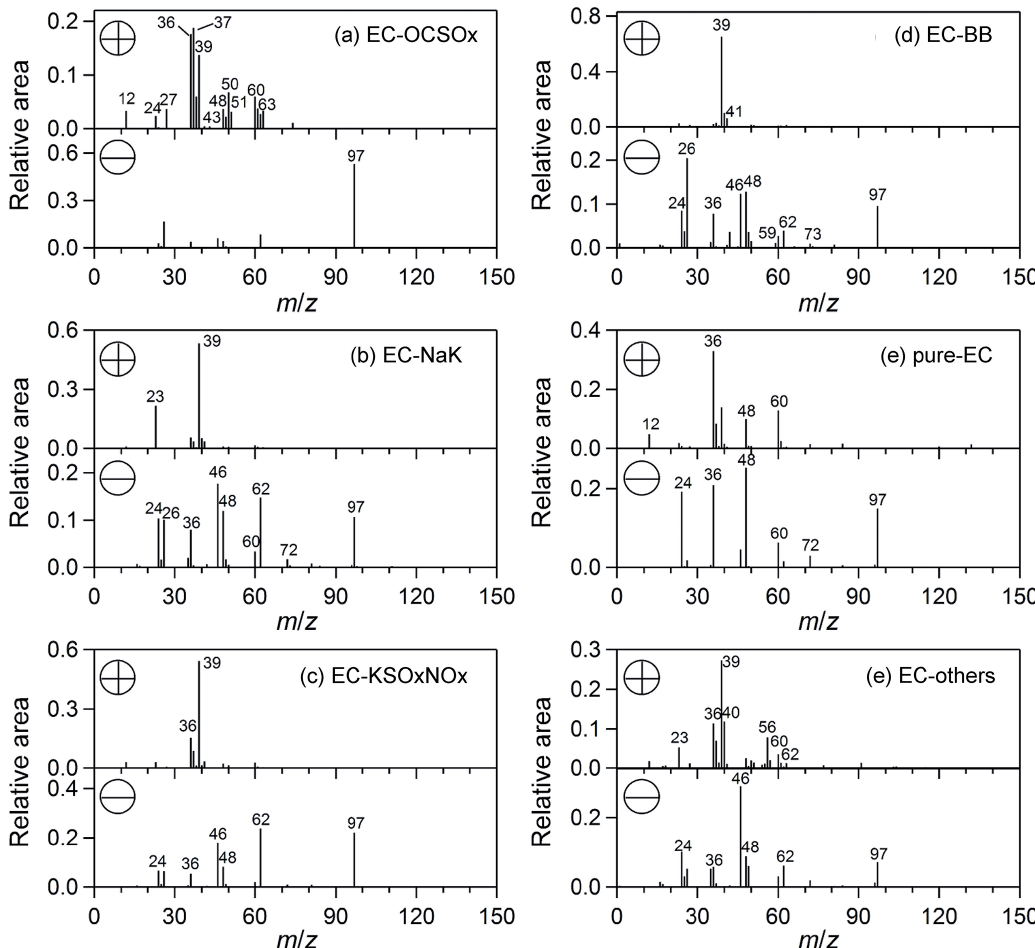
Figure 8. Average mass spectral pattern of six types of elemental carbon (EC)-containing particles.